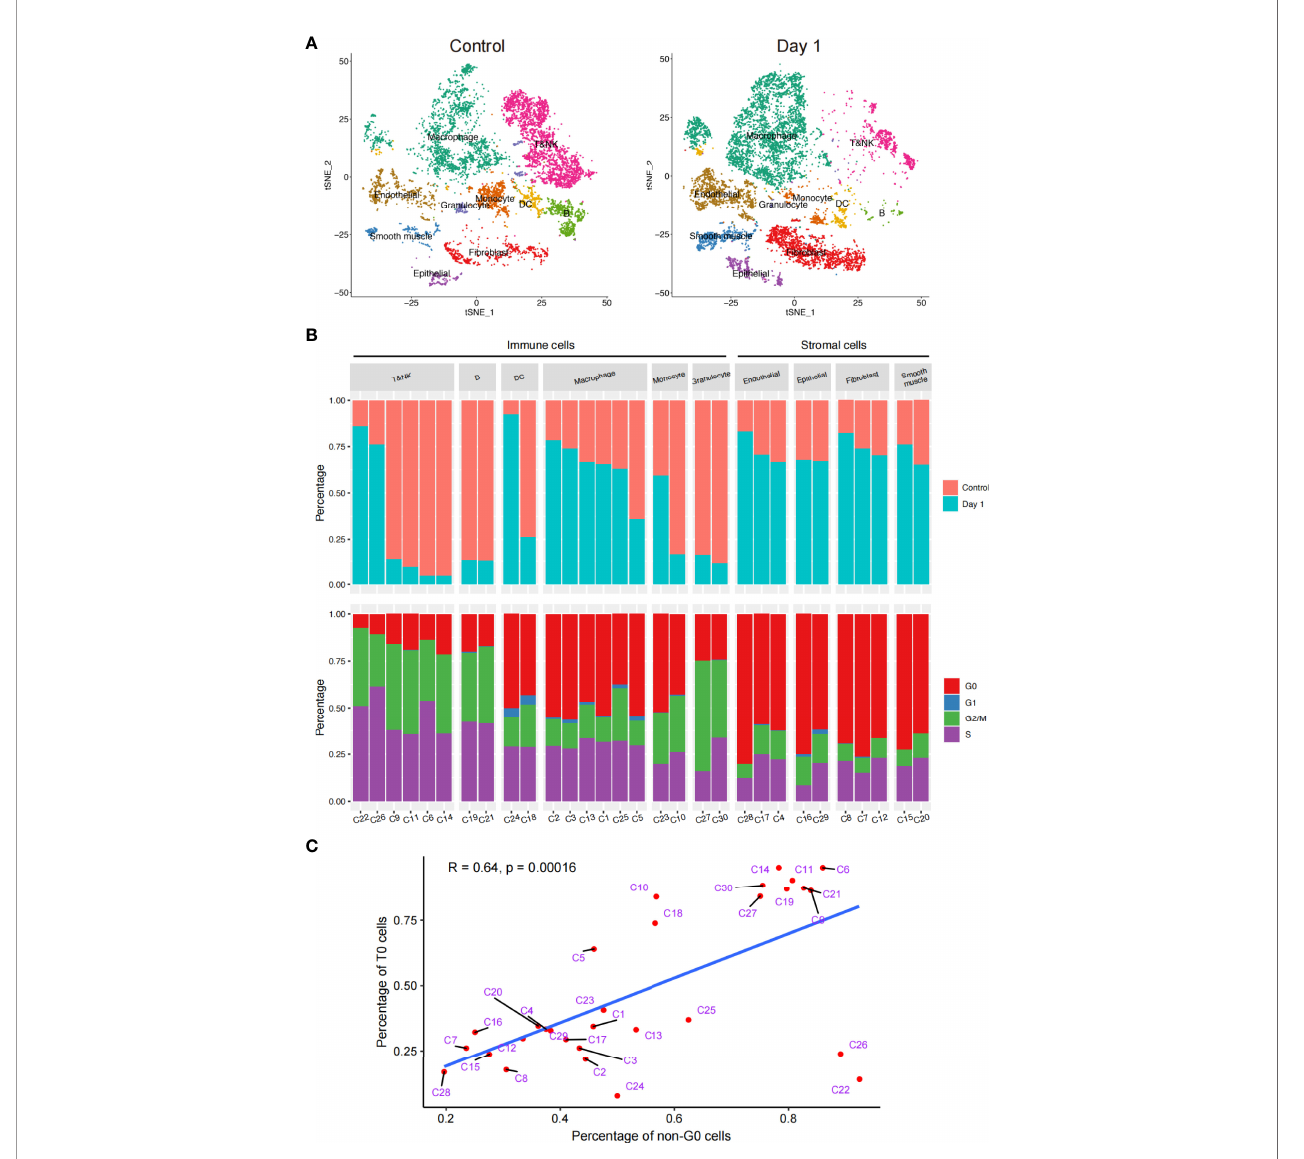
FIGURE 2 | Schematic of the in vivo radiosensitivity of different cell subtypes in the lungs. (A) t-SNE plot of the 18,500 cells, colored by the cell distributions before radiation (left) and after radiation (right). (B) Bar plot (top) showing the fraction of cells before and after radiation in each cluster. Bar plot (bottom) showing the fraction of cells during the cell cycle. Only clusters that had > 50 cells were shown; therefore, cluster 31 has been discarded here. (C) Dot plot of the linear correlation between the ratio of unirradiated cells and G0 phase cells of each cluster, not including cells of cluster